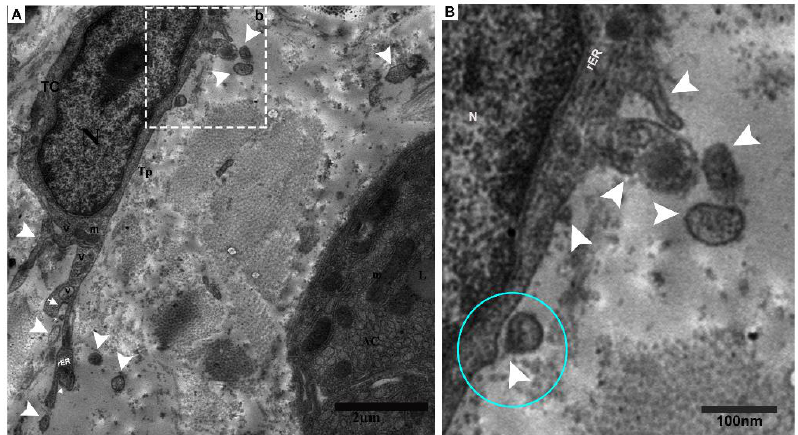
Figure 6. Pinching off vesicles and numerous shading vesicles within the connective tissue. ( A ) The nucleus of TC contains central euchromatin and peripheral heterochromatin, and Tps have visible mitochondria and vesicles. Coated pit releasing shed vesicles (white arrow), as well as multiple releasing and shade vesicles within the connective tissue (white arrowheads), can be seen. The square-marked area ( b ) in ( A ) is inset into ( B ) pinching o ff vesicle (blue circle). The podoms contain rough endoplasmic reticulum and mitochondria, as well as releasing shade / extracellular vesicles (white arrowheads). N, nucleus; TC, telocyte; Tp, telopodes; V, vesicles; m, mitochondria; rER, rough endoplasmic reticulum; LD, lipid droplet; AC, acinus. Scale bar = 2 µ m in ( A ); scale bar = 1 µ m in ( B ).